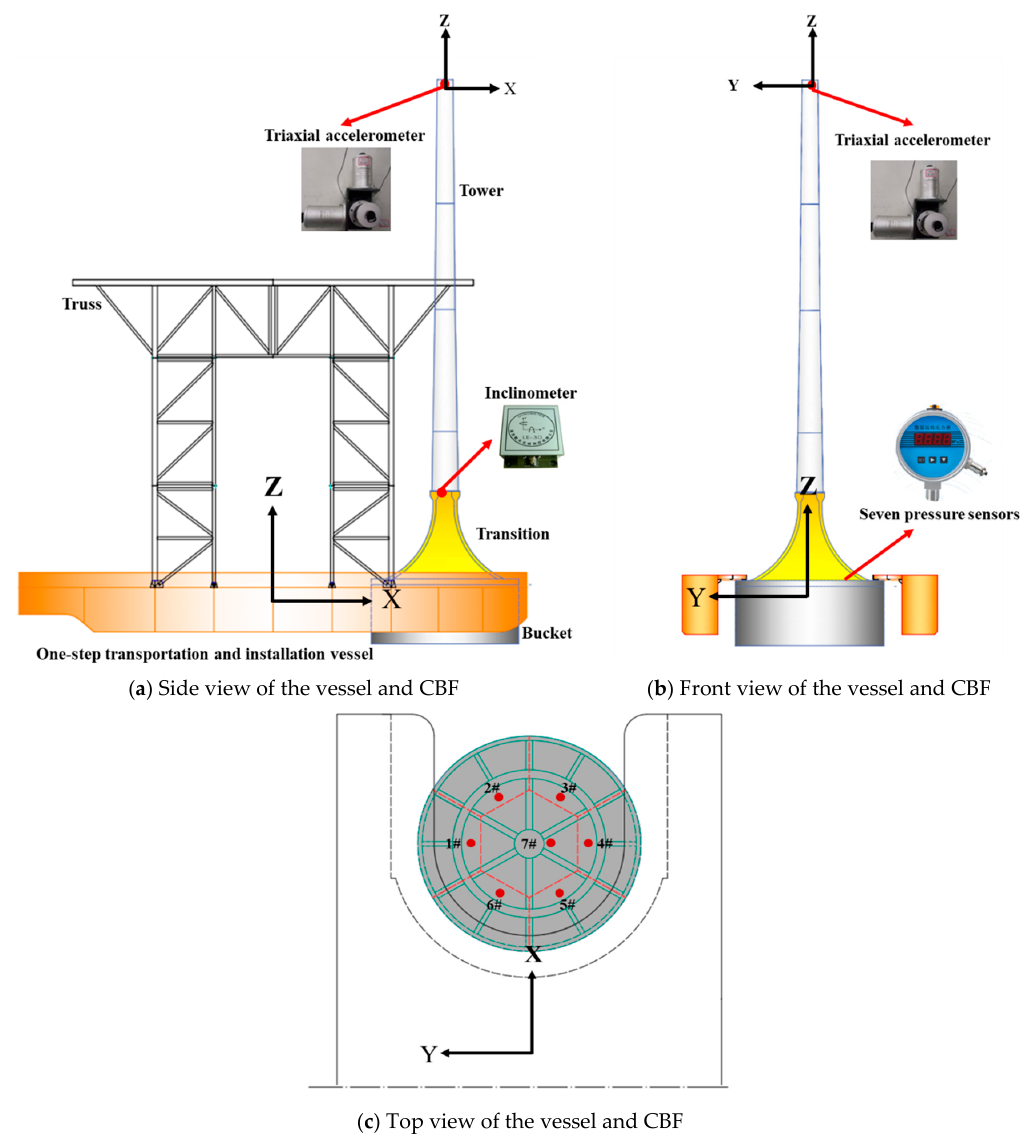
Figure 5. Installed array of sensors.